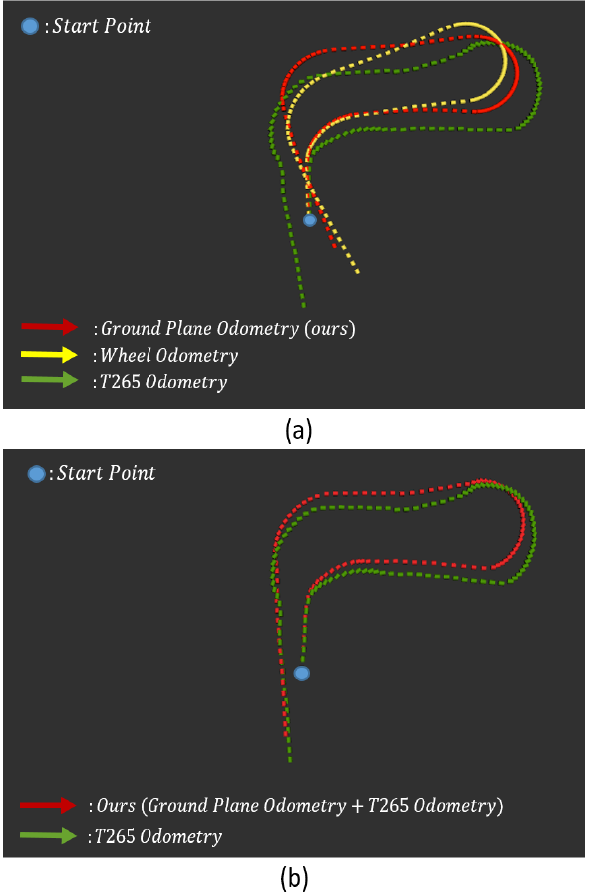
Figure 12 . (a) Compare odometry (b) Trajectory of proposed